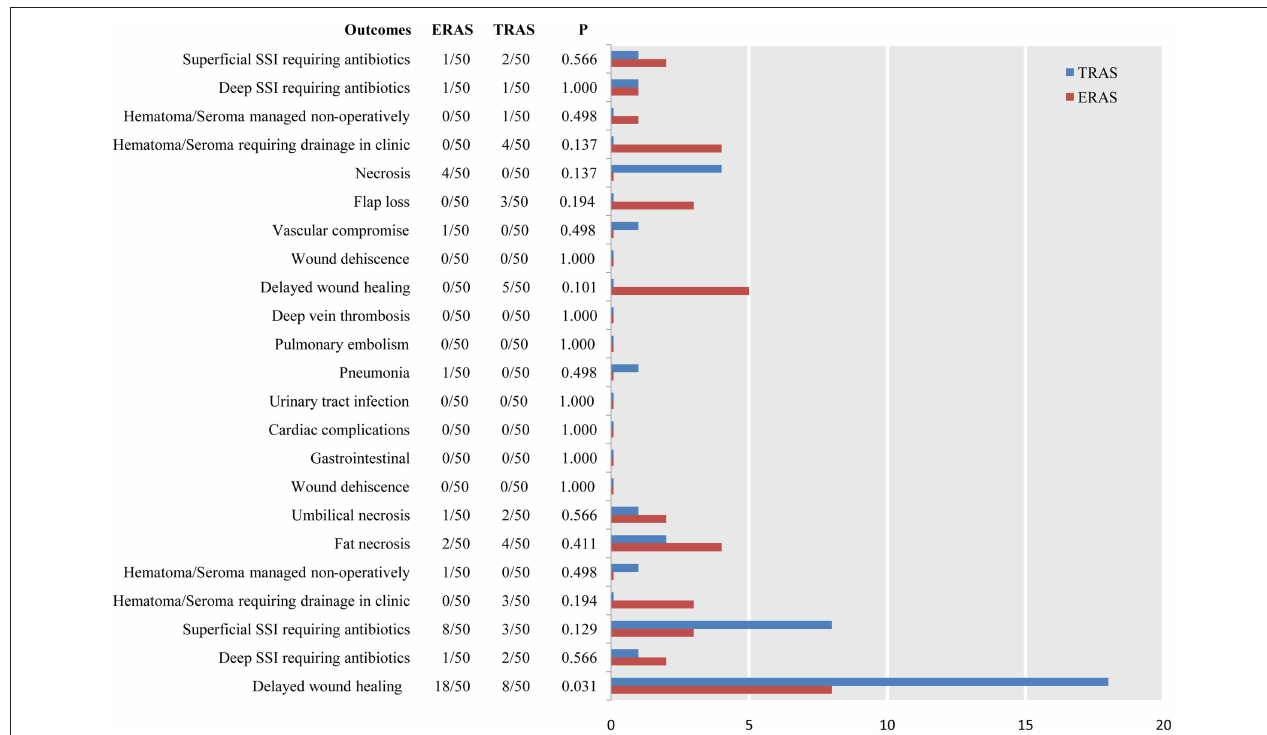
FIGURE 5 | Pooled estimate of the effect of ERAS programs on incidence of breast-related, donor-site, and systemic complications within 45 days after autologous breast reconstruction surgery compared to conventional perioperative care programs.